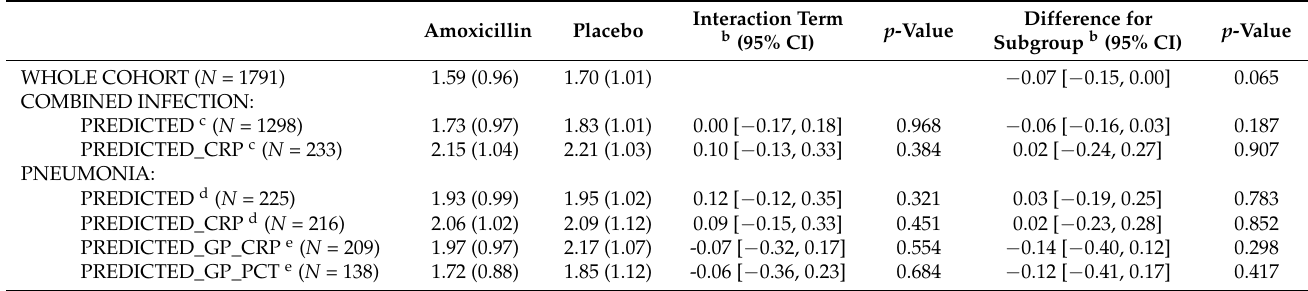
Table 3. Mean symptom severity a (standard deviation) in patients presenting to primary care with acute cough treated with amoxicillin versus